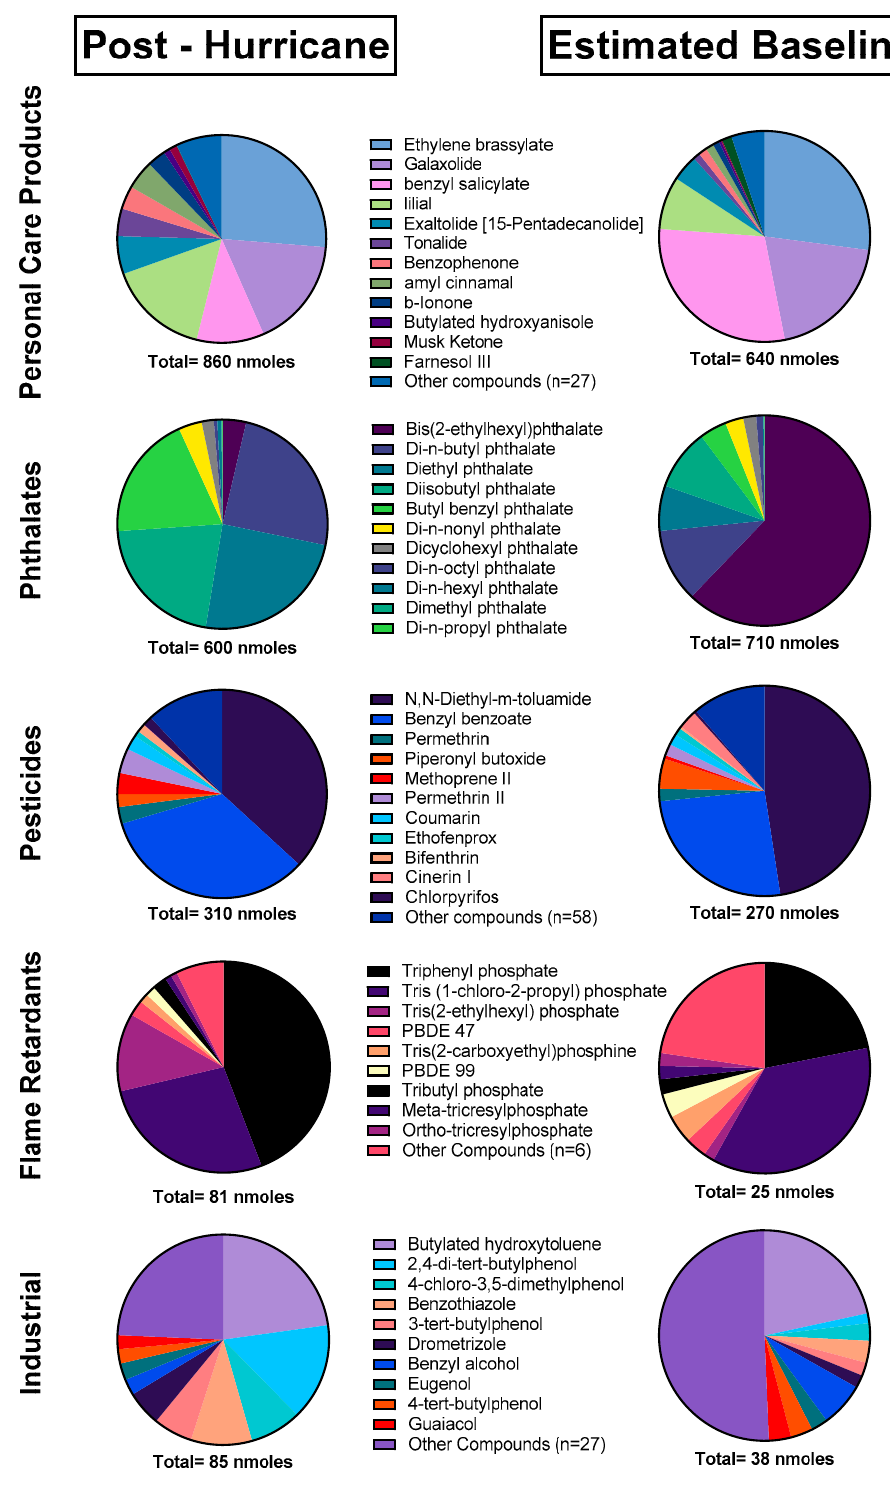
Figure 3. Chemical composition of chemical categories utilized in the 1500 screening method excluding PAHs. All analytes detected at least once in either timepoint were included.